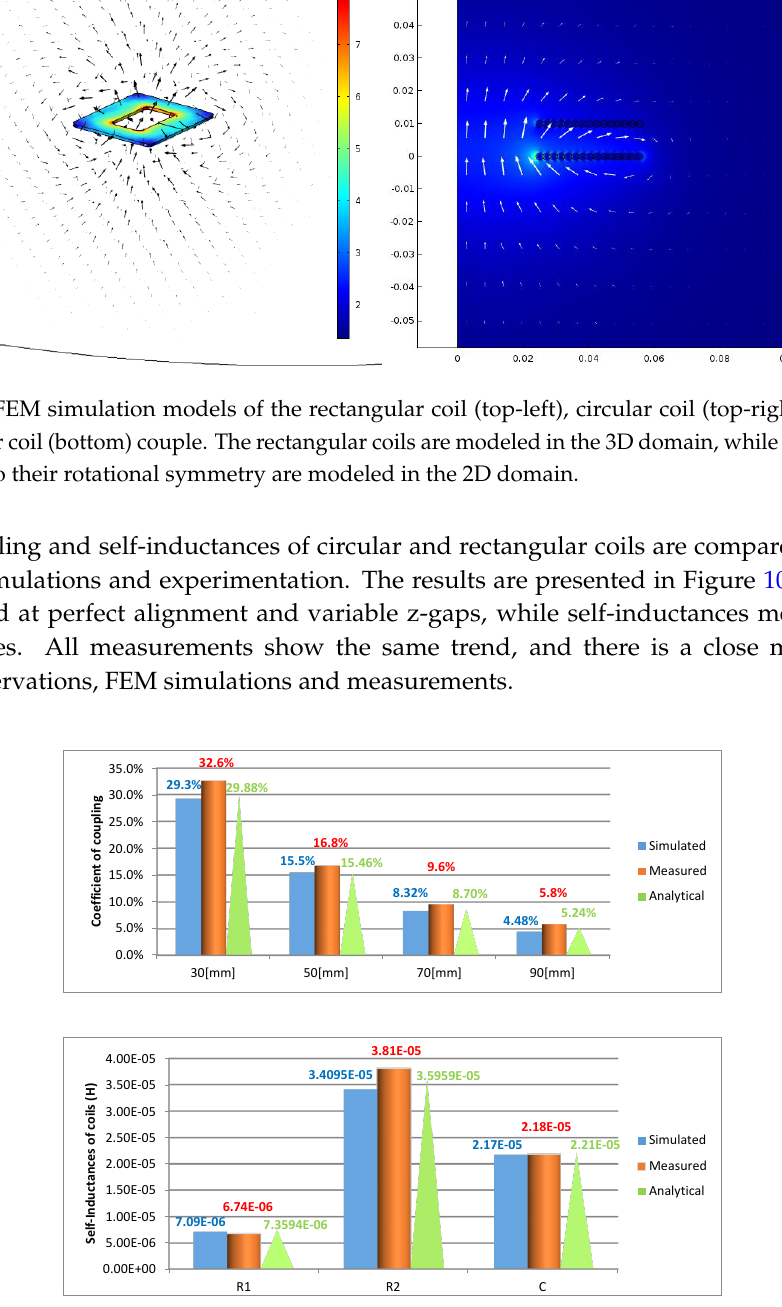
Figure 10. Coupling coefficient and self-inductances of air-cored charge pads of various shapes. The coupling is measured at various z-gaps at the best aligned point. The parameters of the coils are as presented in Table